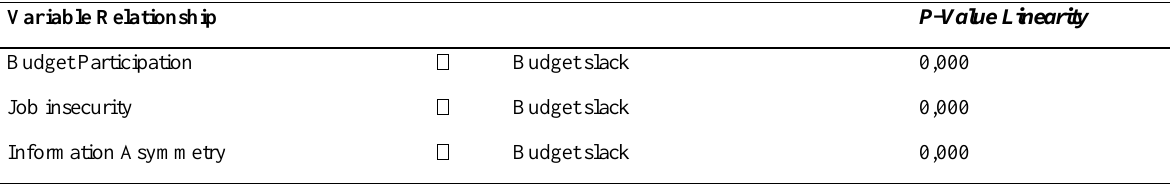
Table 3: Linearity test results